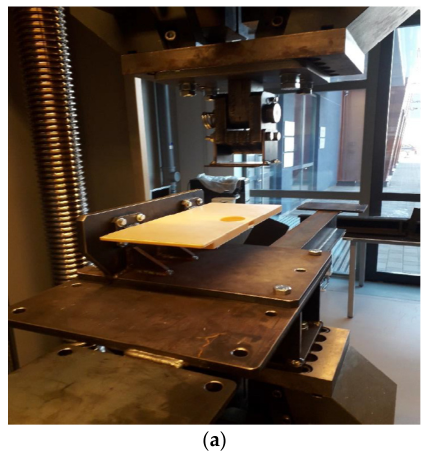
Figure 15. New table webbing design idea ( a ) and Von Mises stress distribution, with the load of 900 N subjected in the middle part ( b ).